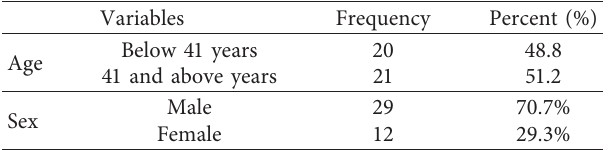
Table 1: Descriptions of sociodemographic factors among patients who developed abdominal wound dehiscence during September 2014 to September 2017 at SPHMMC, Addis Ababa, Ethiopia ( n �